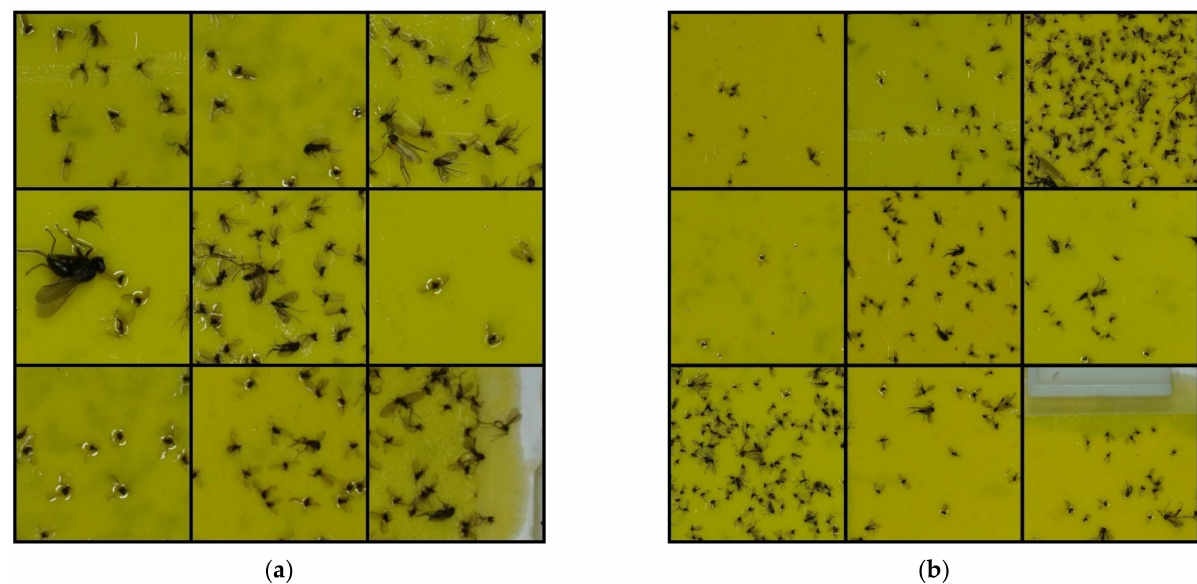
Figure 4. Cropped pheromone trap images: ( a ) 12 × 8 cropping condition; ( b ) 6 × 4 cropping